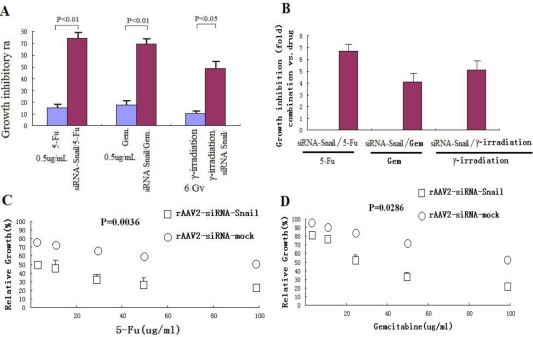
Knockdown of Snail sensitizes pancreatic cancer cells to chemotherapeutic agents and γ-irradiation. PANC-1 cells were treated with chemotherapeutic agents and γ-irradiation, alone or in combination with rAAV2- siRNA-Snail or rAAV2-siRNA-mock (5 MOI), as described in Materials and Methods. Cell growth was measured by MTT assay. (A, B) Growth inhibition of PANC-1 cells after treatment with chemotherapeutic drugs or irradiation alone. 5-FU, 0.5 μg/mL; gemcitabine 0.5 μg/mL; IR, γ-irradiation, 6 Gy. (C, D) Effects of different concentrations of the chemotherapeutic drugs on rAAV2-siRNA-Snail or rAAV2-siRNA-mock infected cells on cell growth. (E, F) The sensitizing effects of Snail knockdown are mediated by enhanced induction of apoptosis. PANC-1 cells were subjected to the indicated treatments and analyzed for apoptosis, as described in Materials and Methods. rAAv was used at 10 MOI. Apoptosis was analyzed by Annexin V/PI assays. 5-FU, 0.5 μg/mL; γ-irradiation, 6 Gy.